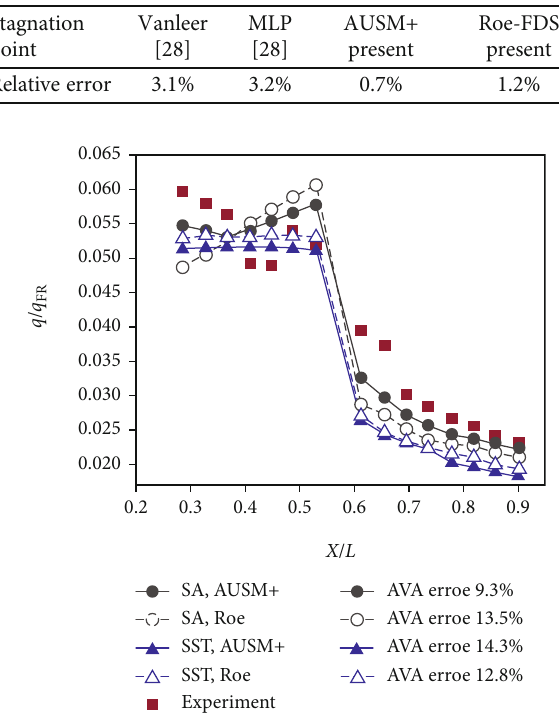
Figure 10: Heat fl ux of blunt biconic for di ff erent schemes.